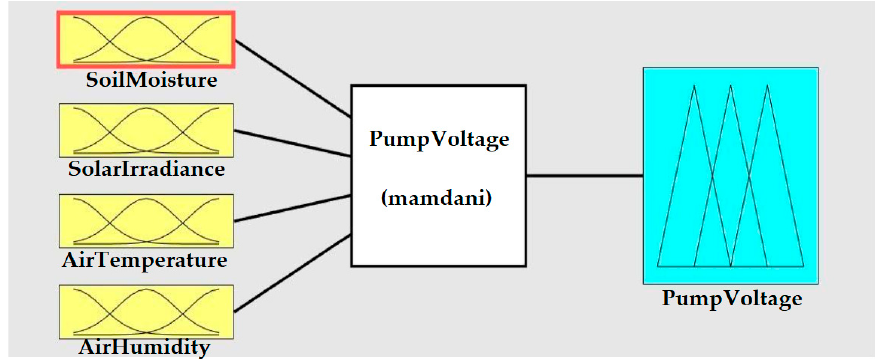
Figure 2. Fuzzy inference system.